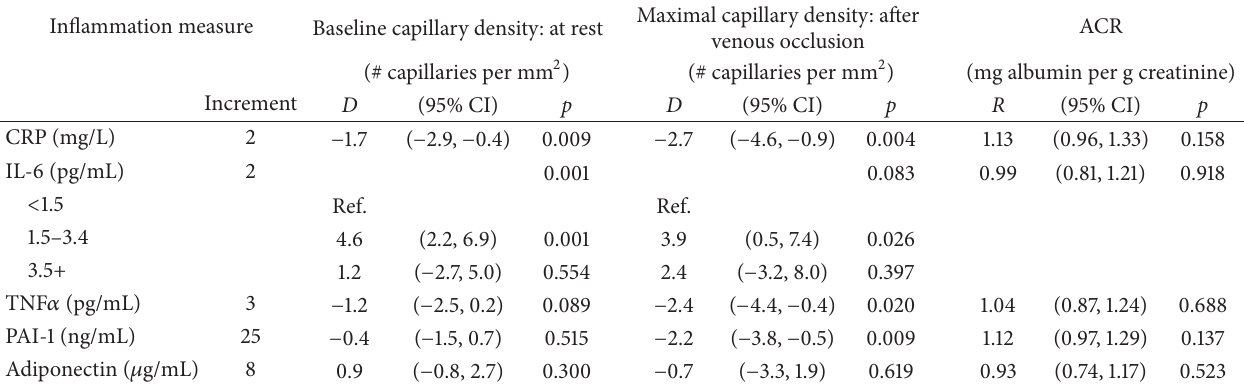
Table 5: Association of the inflammation measures with microvascular structure (capillary densities) and function (ACR). Maximal capillary density: after Inflammation measure Baseline capillary density: at rest ACR venous occlusion (# capillaries per mm 2 )